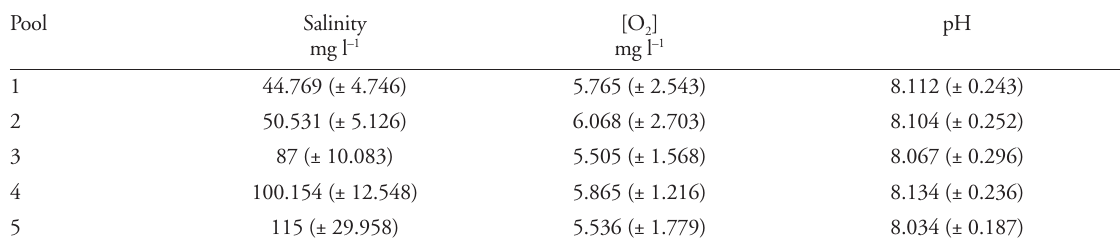
Table A2. Main chemical–physical parameters measured during the field experiment. Values are given as mean (± SD). Pool